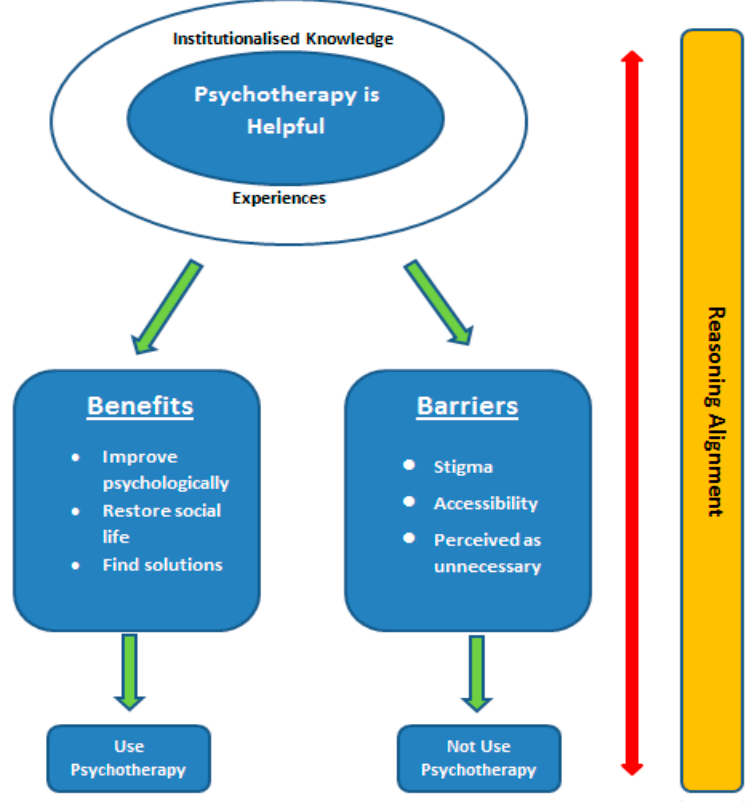
Figure 2. Participants’ understanding of and attitudes towards psychotherapy.